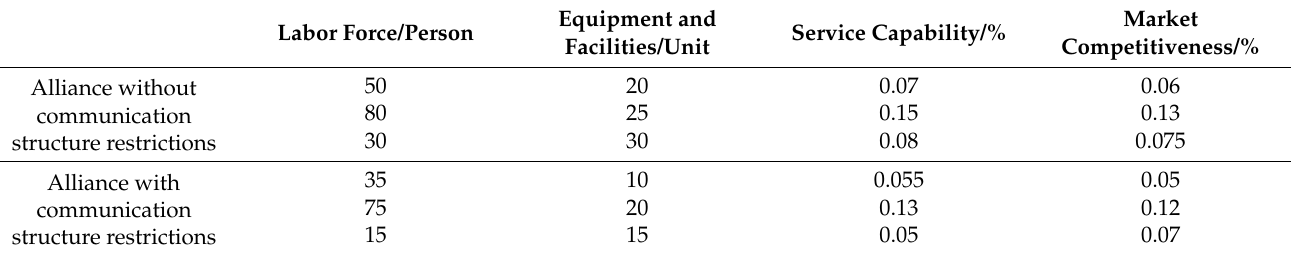
Table 3. Input–output data of each logistics enterprise.